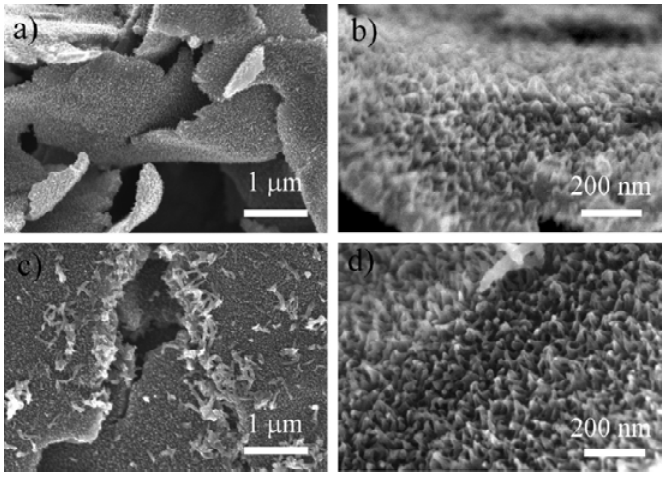
Figure 13. SEM images of vertically grown polyaniline on graphene oxide sheets. Reprinted with permission from [36]. Copyright 2010 American Chemical Society.